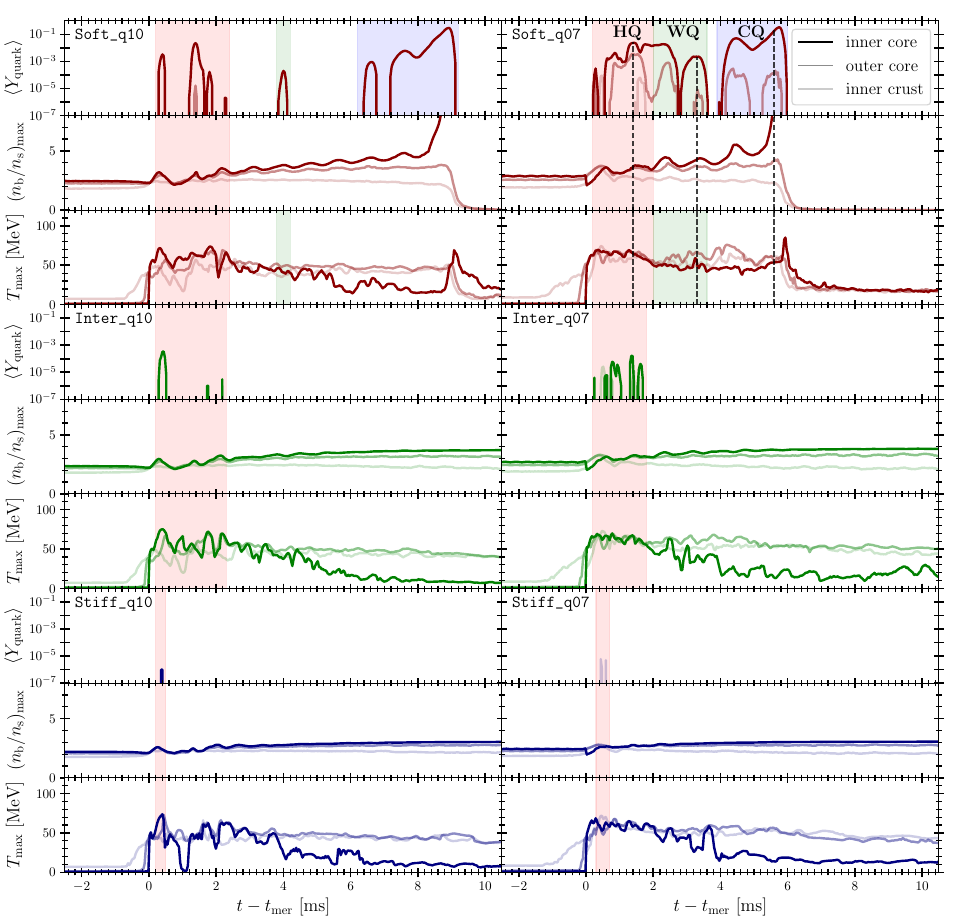
Figure 2: Correlation between the maximal temperature, maximal density and quark fraction in the three regions of interest, for all three equations of state and both mass ratios. We mark the time slices used for Fig. 3 with vertical black lines. The abbreviations HQ, WQ and CQ stand for the hot-quark, warm-quark and the cold- quark stages